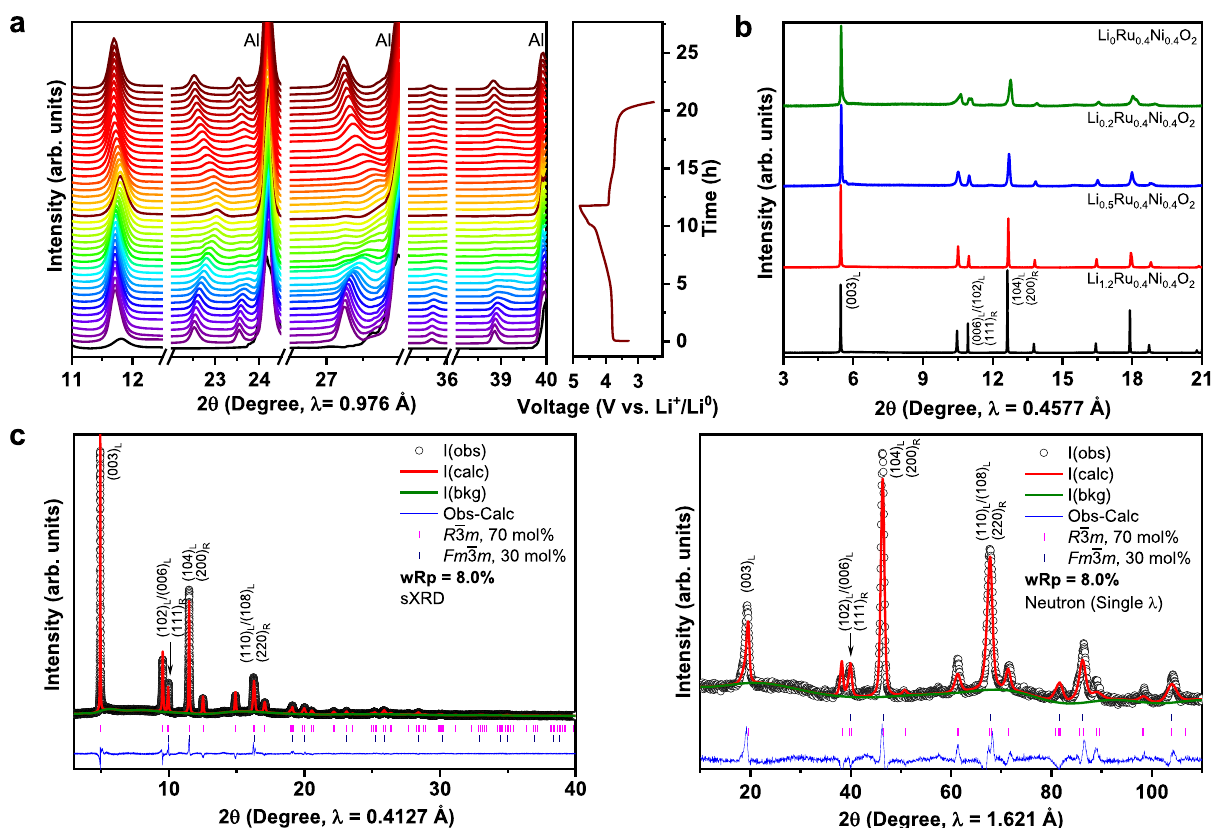
Fig. 3 Nearly zero-strain isotropic structural evolution of Li 1.2 Ni 0.4 Ru 0.4 O 2 upon delithiation/lithiation. a In situ sXRD of Li 1.2 Ni 0.4 Ru 0.4 O 2 , the black pattern at the bottom is the background from the in situ cell; cell was cycled between 4.8 and 2.5 V at C/10. b sXRD of Li x Ni 0.4 Ru 0.4 O 2 ( x = 1.2, 0.5, 0.2, 0)